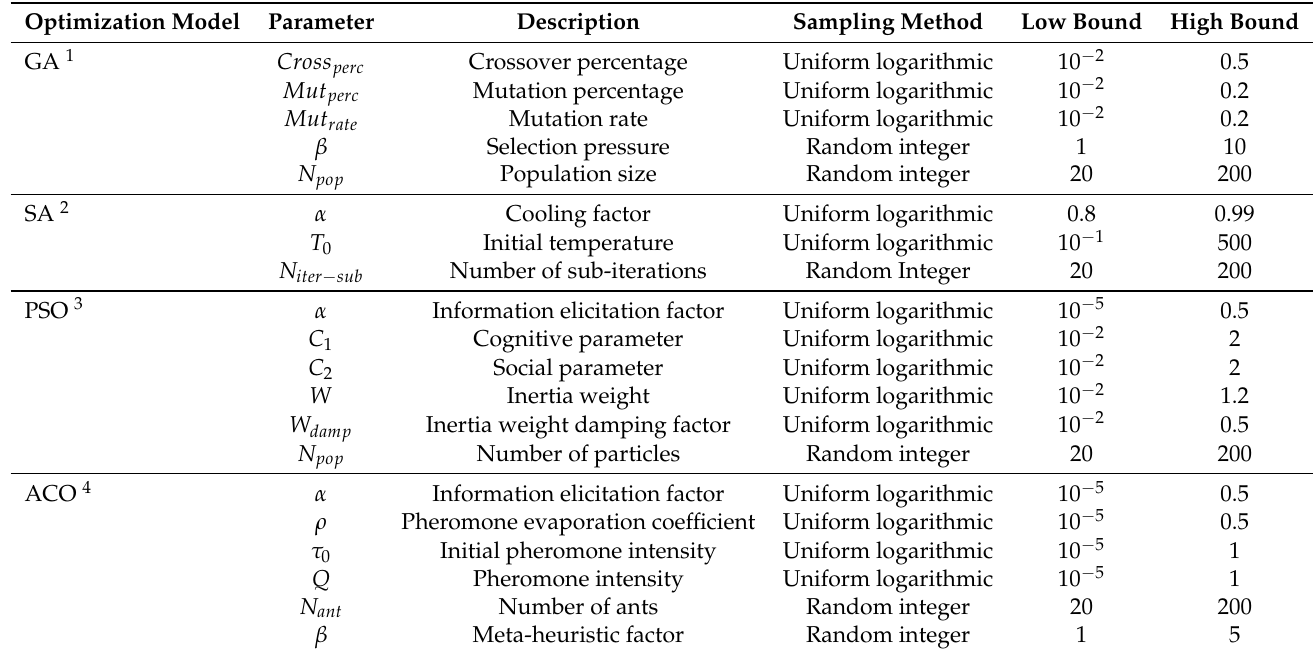
1 Genetic Algorithm; 2 Simulated Annealing; 3 Particle Swarm Optimization; 4 Ant Colony